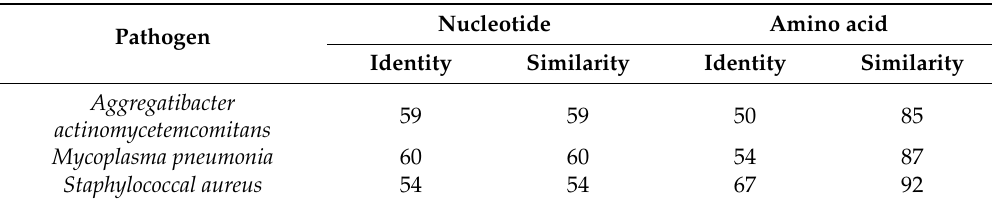
Table 1. Identity and similarity of bacterial GAPDH and streptococcal GAPDH (nephritis-associated plasmin receptor;